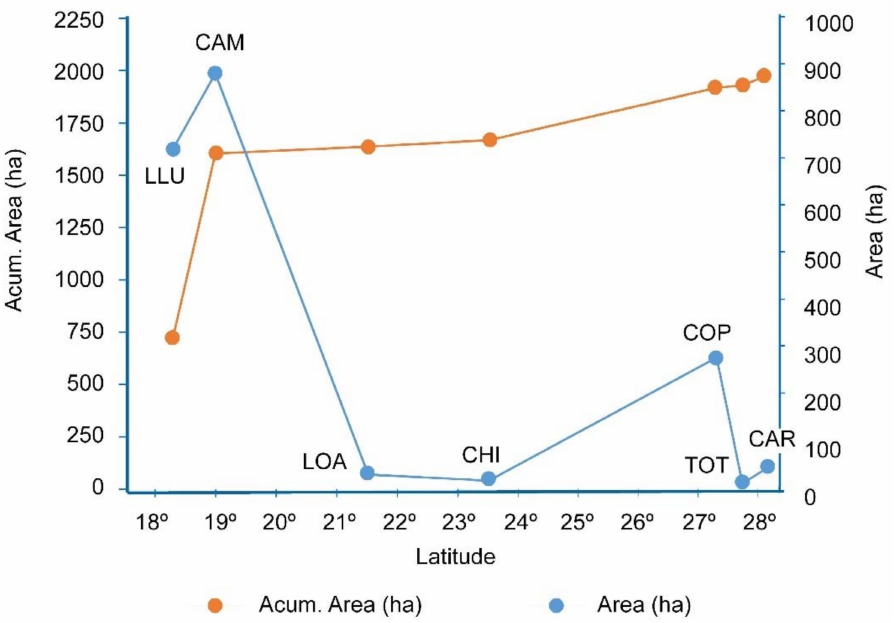
Figure 4. Area and accumulated area of the wetlands analyzed in this work according to latitude. The abbreviated name of the wetlands is located over its area (see Figure